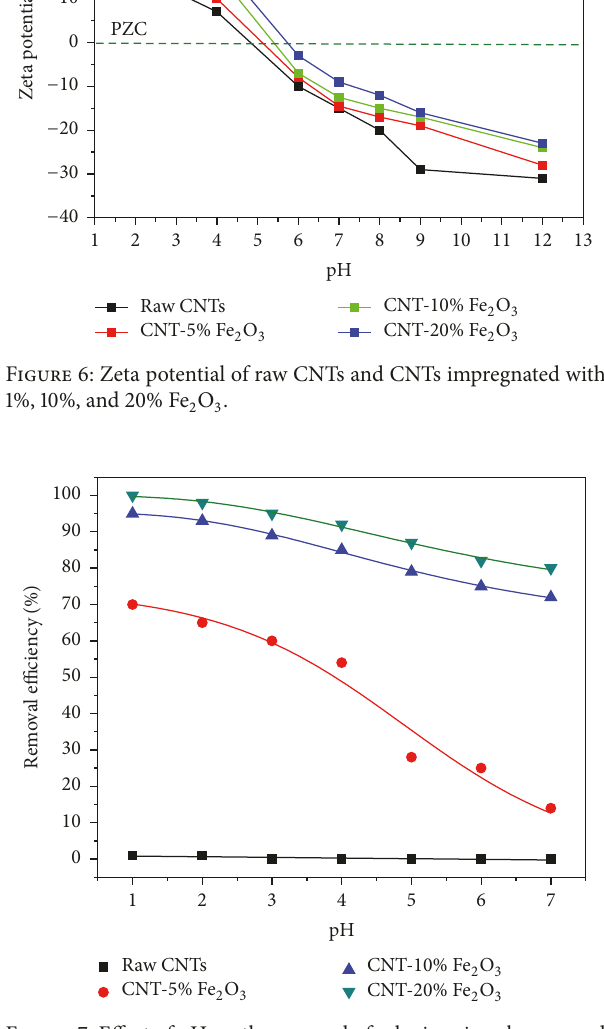
Figure 7: Effect of pH on the removal of selenium ions by raw and impregnated CNTs with different loading of iron oxide (agitation speed = 50 rpm, CNTs dosage = 10mg, time = 6 hr, and initial con- centration =